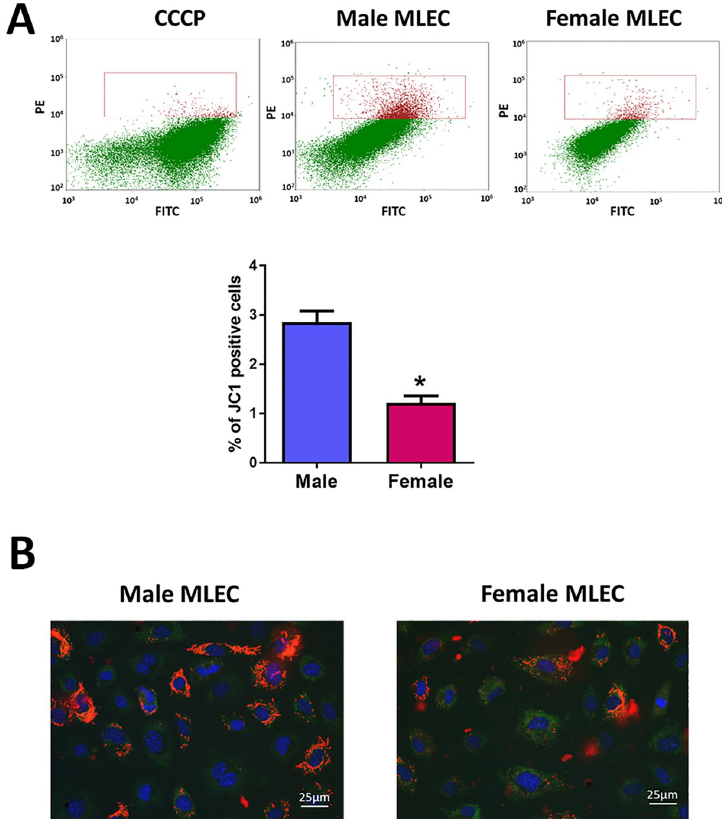
Fig 3. Mitochondrial membrane potential in male and female MLEC. MLEC isolated from male mice show a significantly higher level of mitochondrial polarization. A –representative flow cytometry plots and gating strategy (upper panel). MLEC stained by JC1 in the presence of mitochondria depolarizer CCCP were gated to exclude polarized cells. The same gates were used to determine the level of polarization in untreated male and female MLEC. Quantitate analysis of JC1 positive cells (lower panel). Values are means ± SEM; N = 4 repetitions from 5–7 mice isolated for each sex. � p < 0.05 versus male MLEC. Statistical analysis was performed using the unpaired t-test. B – Representative fluorescent images show a higher percentage of cells with polarized mitochondrial in male MLEC